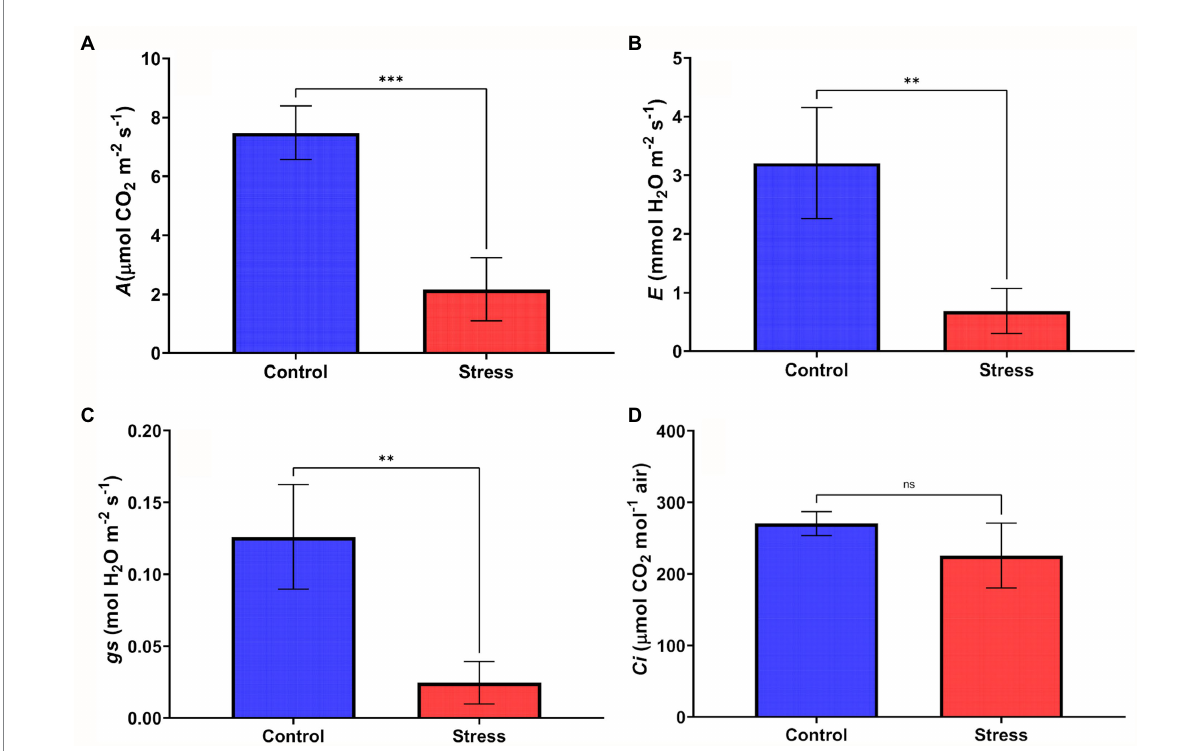
FIGURE 2 Gas exchange rates in leaves of young oil palm plants subjected to 14 days of drought stress in greenhouse conditions: (A) net CO 2 assimilation rate – A ; (B) transpiration rate – E ; (C) stomatal conductance – gs ; and (D) intercellular CO 2 concentration – Ci . After submitting the gas exchange data to the Kruskal-Wallis test, Dunn’s test ( p < 0.05) was applied to data with significant differences between treatments. ns - not significantly different, and ** or *** - significantly